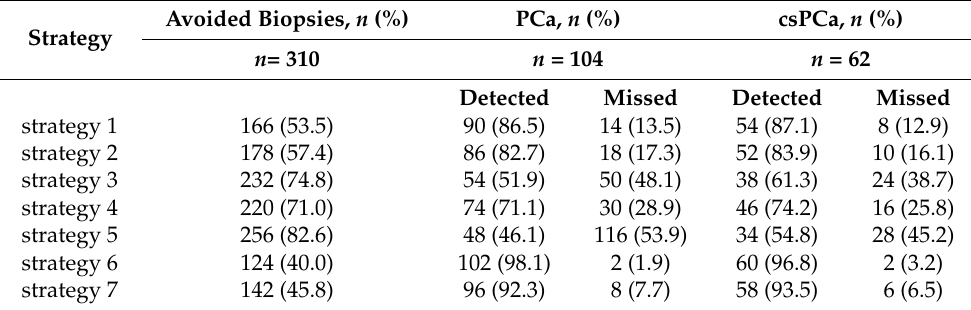
Table 3. Prostate cancer (PCa) and clinically significant prostate cancer (csPCa) detection rate, avoided biopsies and missed PC and csPC among the study population according to different